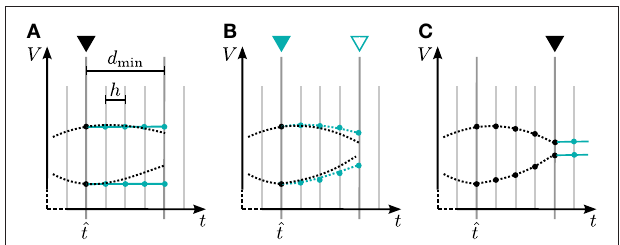
FIGURE 5 | Iterative neuronal updates. Communication of spikes and gap-junction related data is carried out in steps of d min (long gray lines), which denote the minimum synaptic transmission delay in the network. Within each communication interval neurons update their dynamics in steps of h (shorter light gray lines); here d min = 4 h at time ˆ t . Turquoise curves show the approximation of the membrane potential, which is used by the connected neuron to compute the solution in the current interval. (A) First iteration with constant approximation for the membrane potential of the connected neuron. At the end, a new approximation of the just computed membrane potential is passed to the connected neurons. (B) Further iteration with the approximation of the membrane potential from last iteration. This part is the actual iteration process which can be done multiple times. (C) After the final iteration a constant extrapolation for the next time step is communicated.